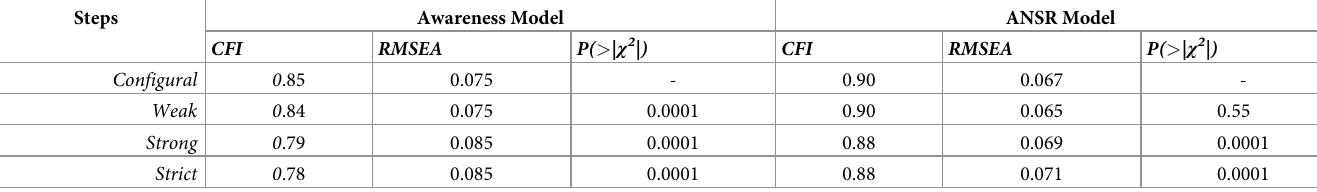
Table 3. Measurement invariance analysis per awareness and ANSR model.